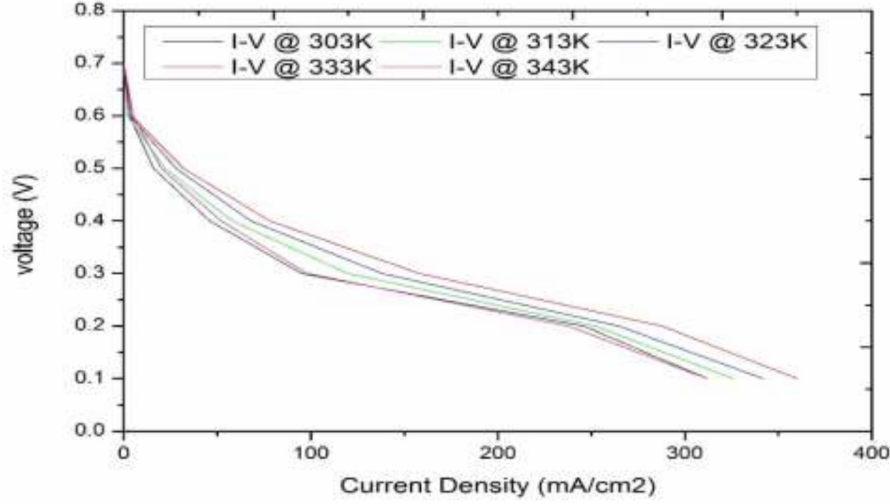
Figure 9. C CH3OM : Steady-state current density–voltage